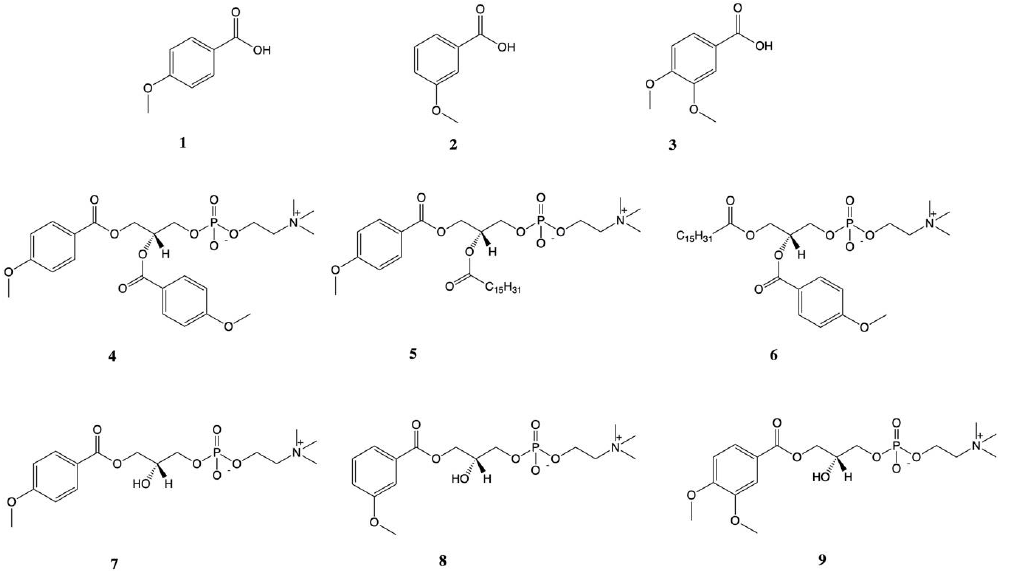
Figure 1. Studied methoxy derivatives of benzoic acid: p -anisic acid ( 1 ), 3-methoxybenzoic acid ( 2 ), veratric acid ( 3 ), and synthesized corresponding O -methylated phenophospholipids: 1,2-dianisoyl- sn -glycero-3-phosphocholine ( 4 ), 1-anisoyl-2-palmitoyl- sn -glycero-3-phosphocholine ( 5 ), 1-palmitoyl-2- anisoyl- sn -glycero-3-phosphocholine ( 6 ), 1-(3-methoxy)benzoyl-2-hydroxy- sn -glycero-3-phosphocholine( 8 ),and1-veratroyl-2-hydroxy- sn -glycero-3- phosphocholine ( 9